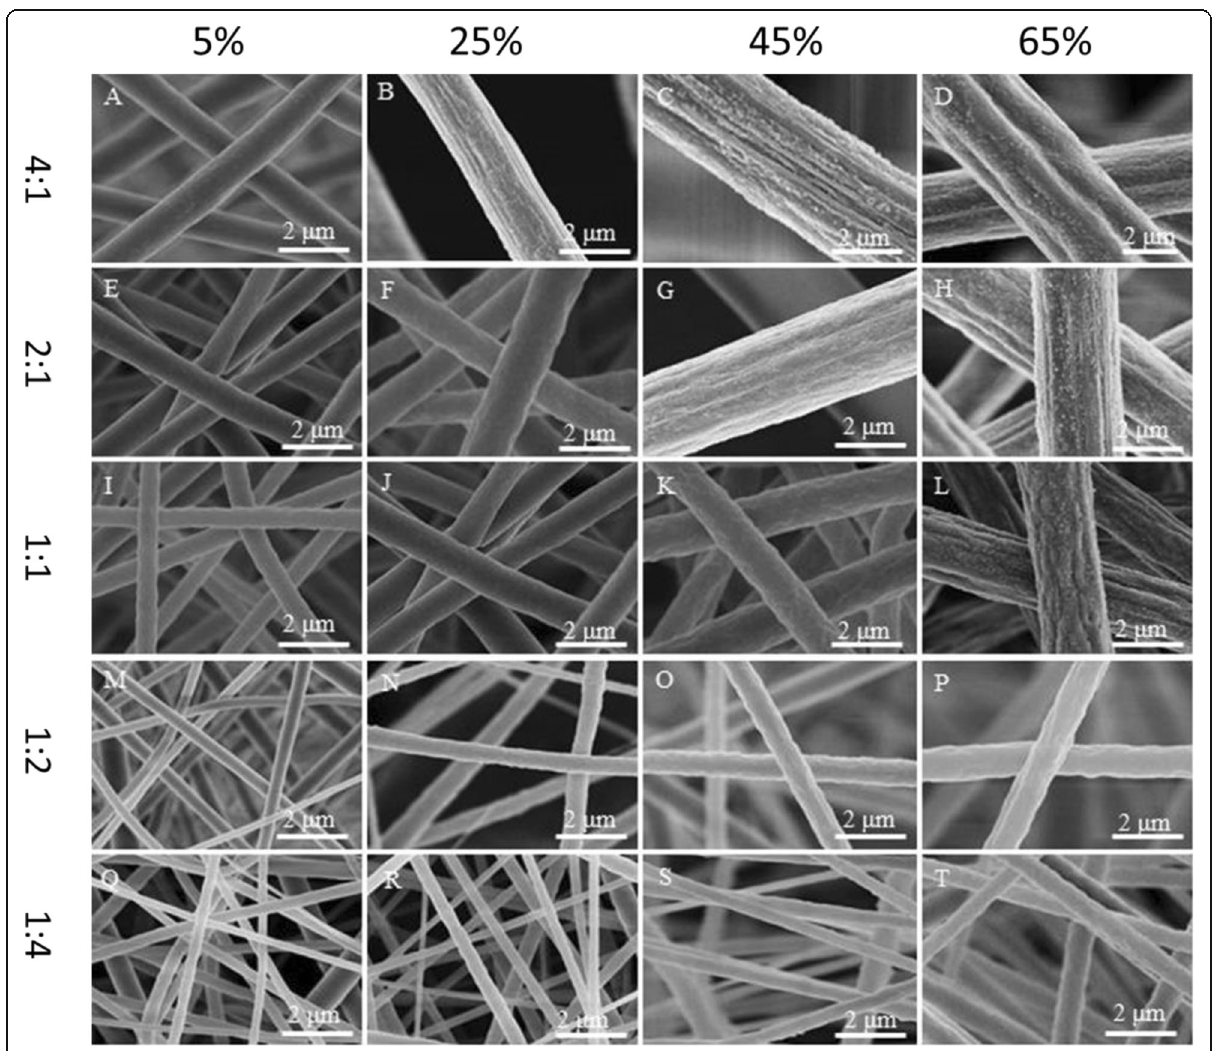
Fig. 6 Representative SEM images of samples fabricated by electrospinning 25% ( w / v ) PVDF solutions from ACE/DMF at different levels of